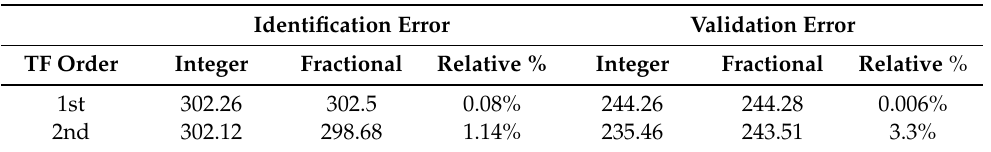
Table 2. Furnace approximation errors. Computed as (cid:107) y − ˜ y (cid:107) , where y are the experimental data, ˜ y are the approximated data and (cid:107) · (cid:107) is the Euclidean norm. The relative percentage expresses the difference between the errors committed by the two models in a proportion of the